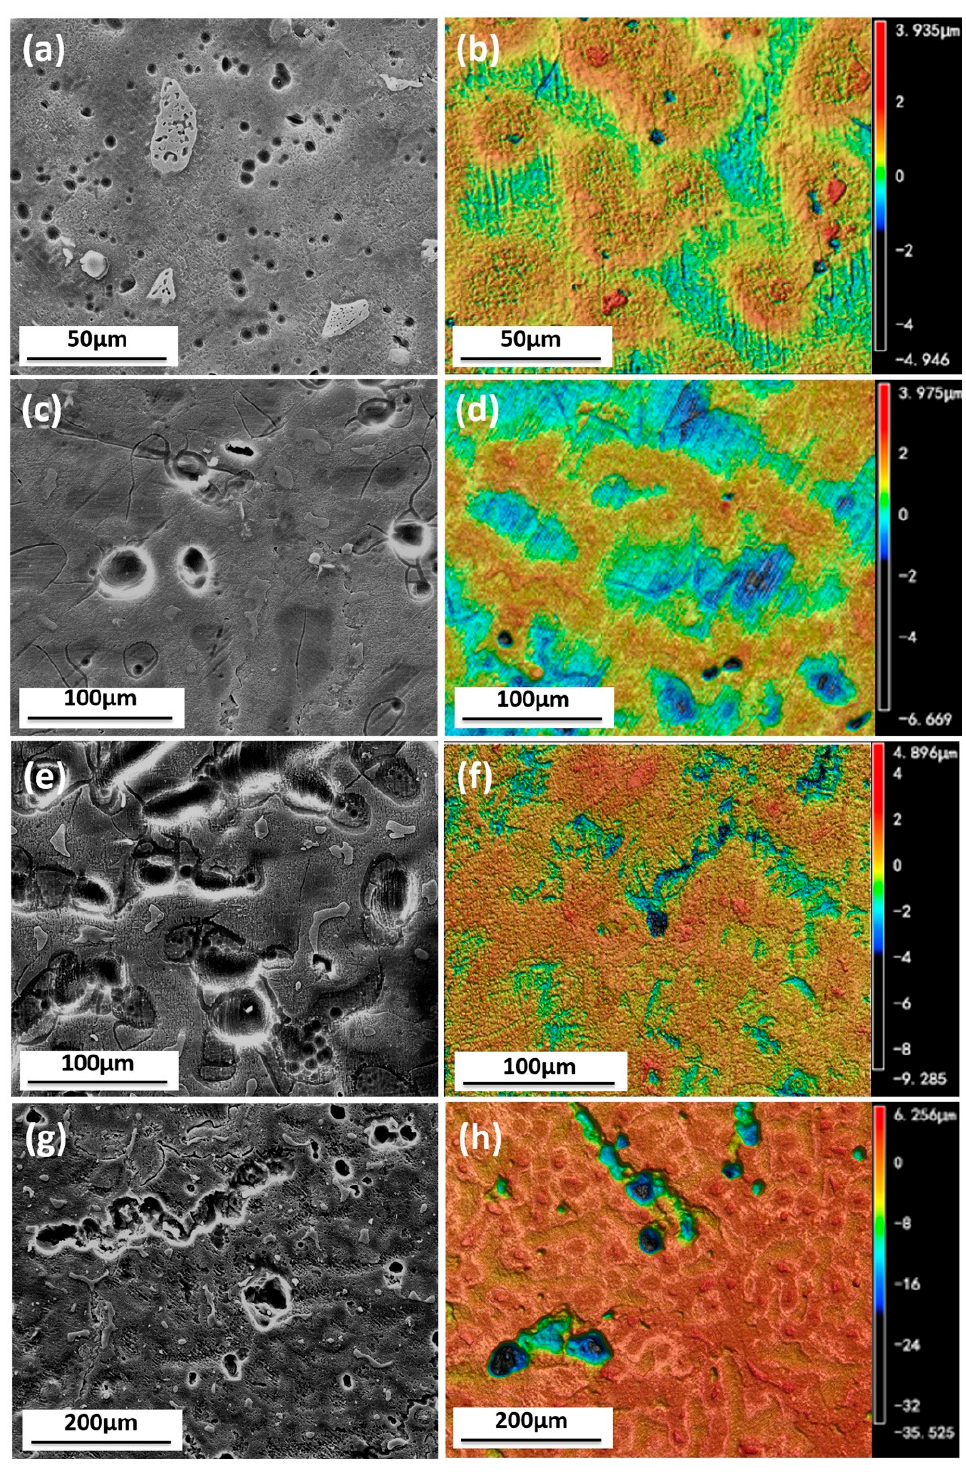
Figure 9. SEM ( a , c , e , g ) and CLSM ( b , d , f , h ) images of samples immersed in solution for 1.5 h ( a , b ), 3 h ( c , d ), 8 h ( e , f ) and 48 h ( g , h ) after rust removal.